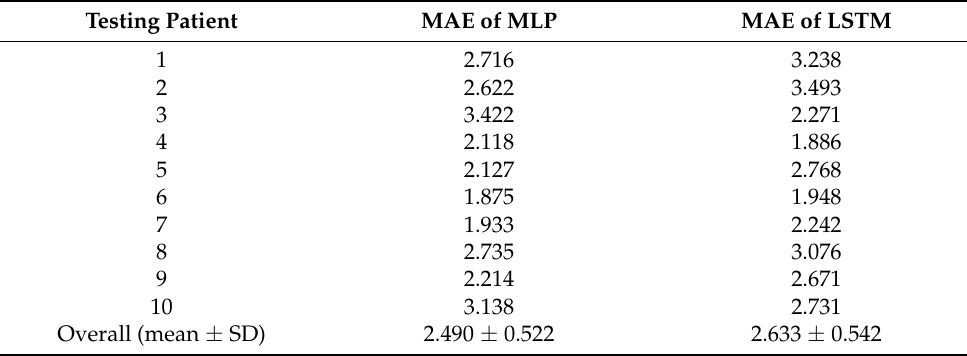
Table 3. Prediction MAEs from both models using the holdout method.